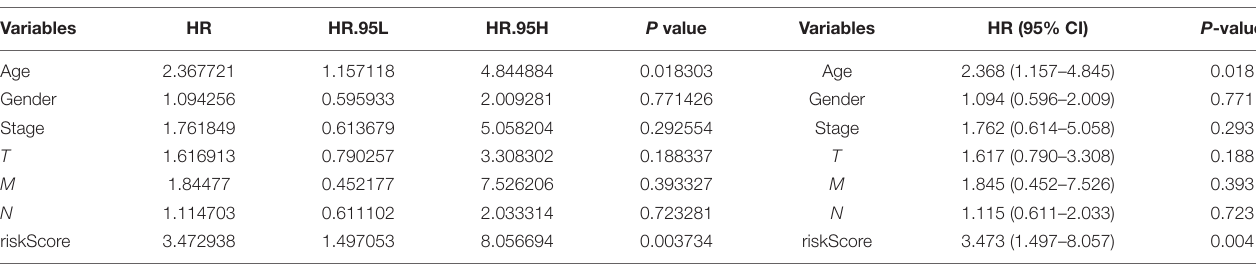
FIGURE 6 | Independence of immune-related prognostic signature from clinical factors. (A) Forest plot for univariate analysis of overall survival of TCGA CRC patients. (B) Forest plot for multivariate analysis of overall survival of TCGA CRC patients. Red dots represent high-risk factors. TABLE 5 | Multivariate analyses of overall survival in CRC patients of TCGA.